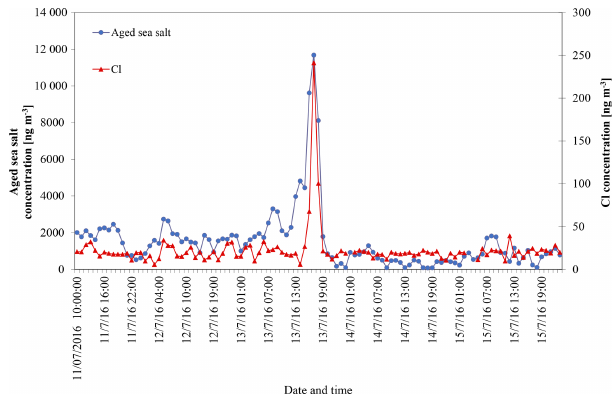
Figure 4. Temporal patterns of an aged sea salt source retrieved from the multi-time resolution model and Cl concentrations mea- sured in atmospheric